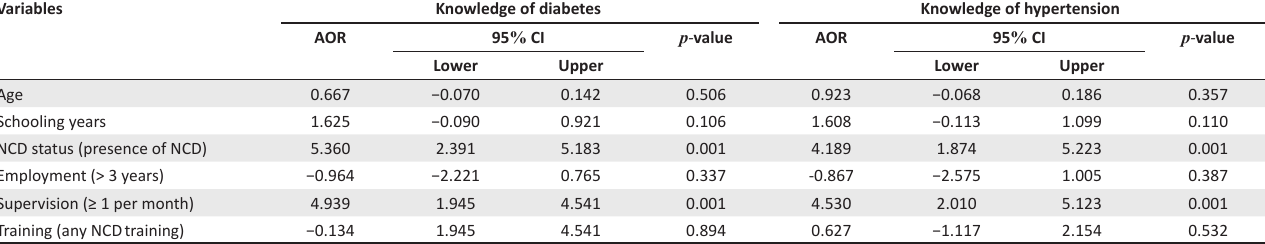
TABLE 4: Multiple regression model of factors associated with diabetes and hypertension knowledge.